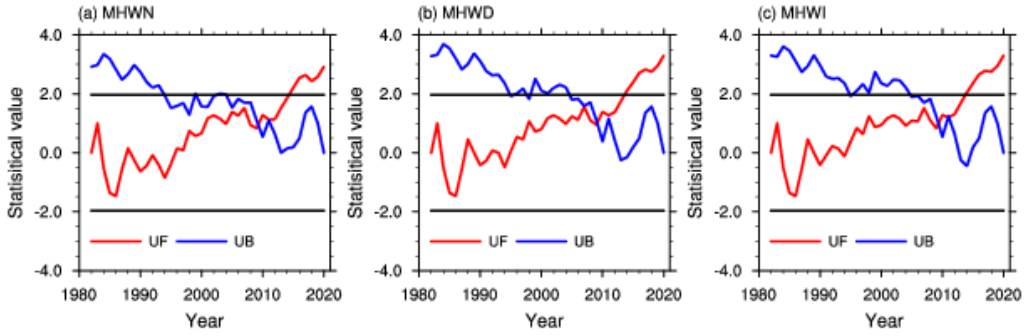
Figure 6. Mann – Kendall test for time series of indices from 1982 to 2020, ( a ) MHWN, ( b ) MHWD, ( c ) MHWI. A significant abrupt change occurs if the UF and UB curves intersect within the confidence zone. Here, the current study used a 95% confidence level (1.96 and − 1.96) as the confidence zone’s borderlines.